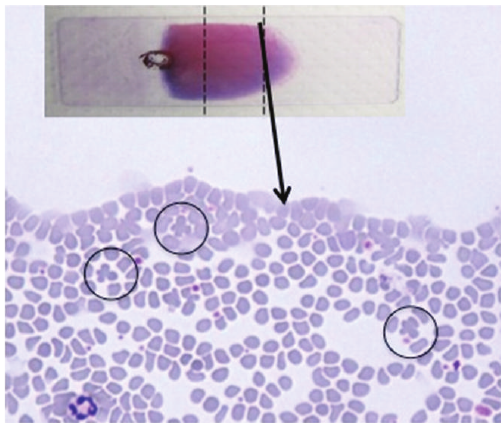
Figure 1: Few qRBCs seen (black circle) at the smear side adjacent to the body-feathered area (20x, May-Grundwald Giemsa).